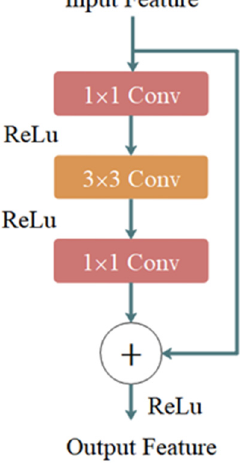
Figure 5. ResNet50 Block structure. Where: ReLu represents the rectified linear units. Conv represents the convolution layer.